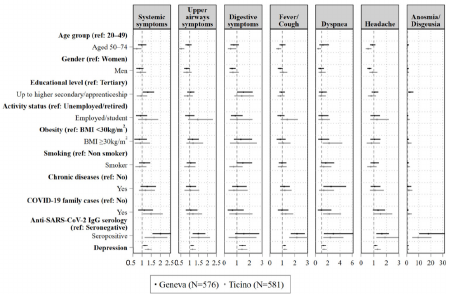
Figure 2. Results of Poisson regressions estimating likelihoods of reporting COVID-19 symptoms at baseline across studies. Note: values are prevalence ratios with 95% confidence intervals from Poisson regressions with robust standard errors, adjusted for all listed variables. For Geneva, analyses were further adjusted for the year of PHQ-9